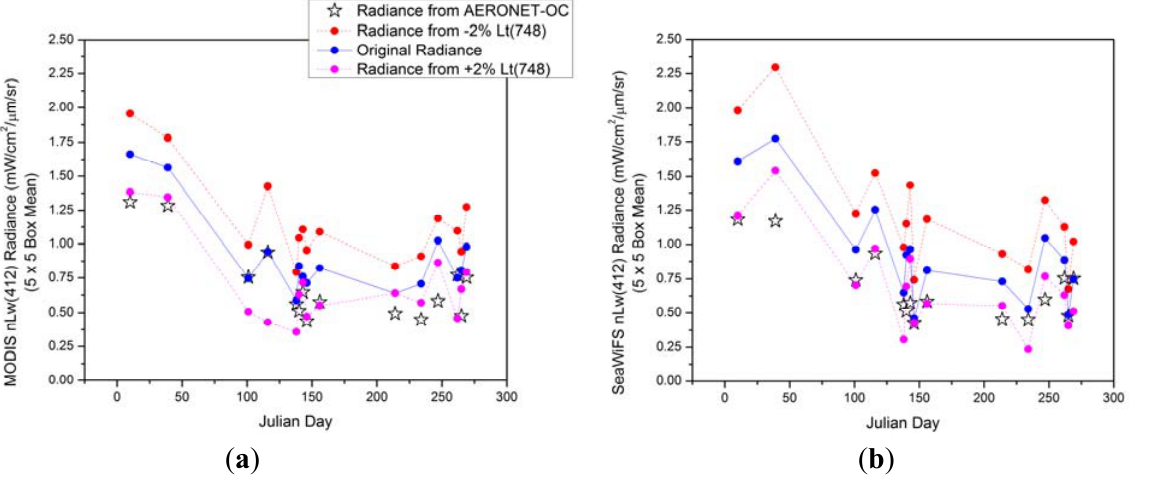
L (547) and SeaWiFS n w